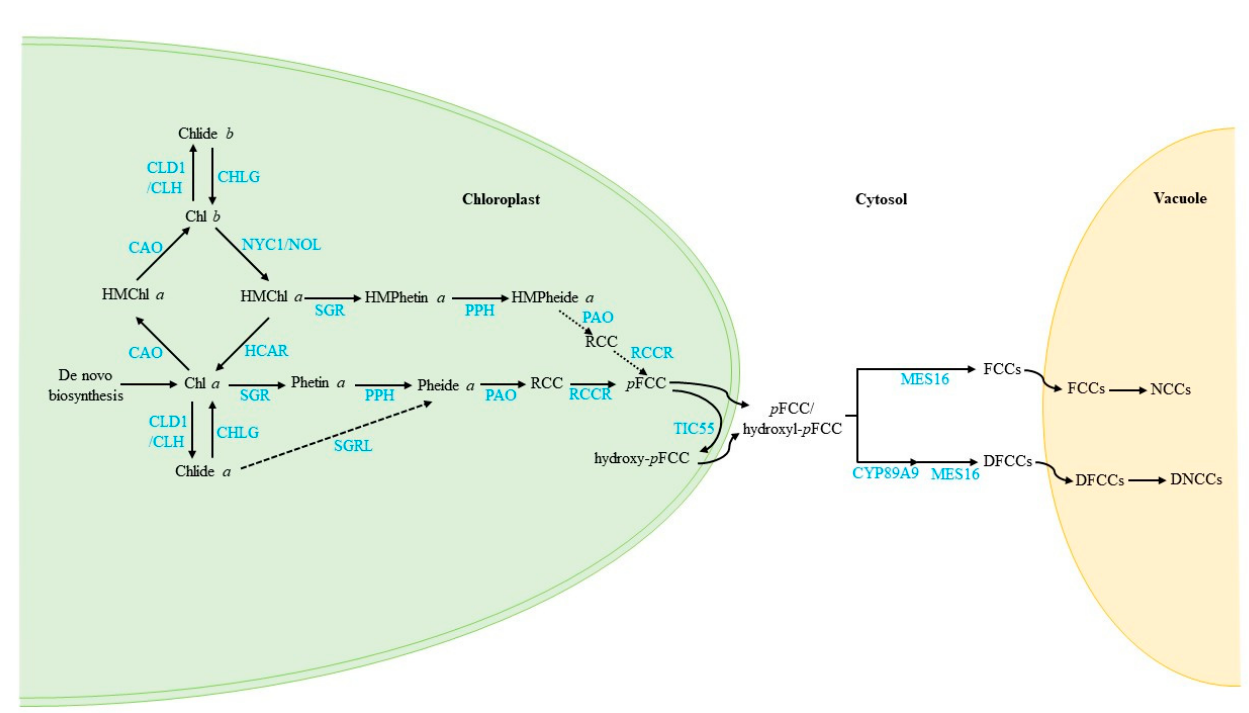
Figure 4. Updated model of the Chl cycle, turnover and degradation pathways in plants. The model shows the subcellular localisation (bold black characters), representative intermediates (black characters) and enzymes (blue characters). Arrows show metabolic pathways; dotted arrows indicate the proposed pathways that need further investigation.